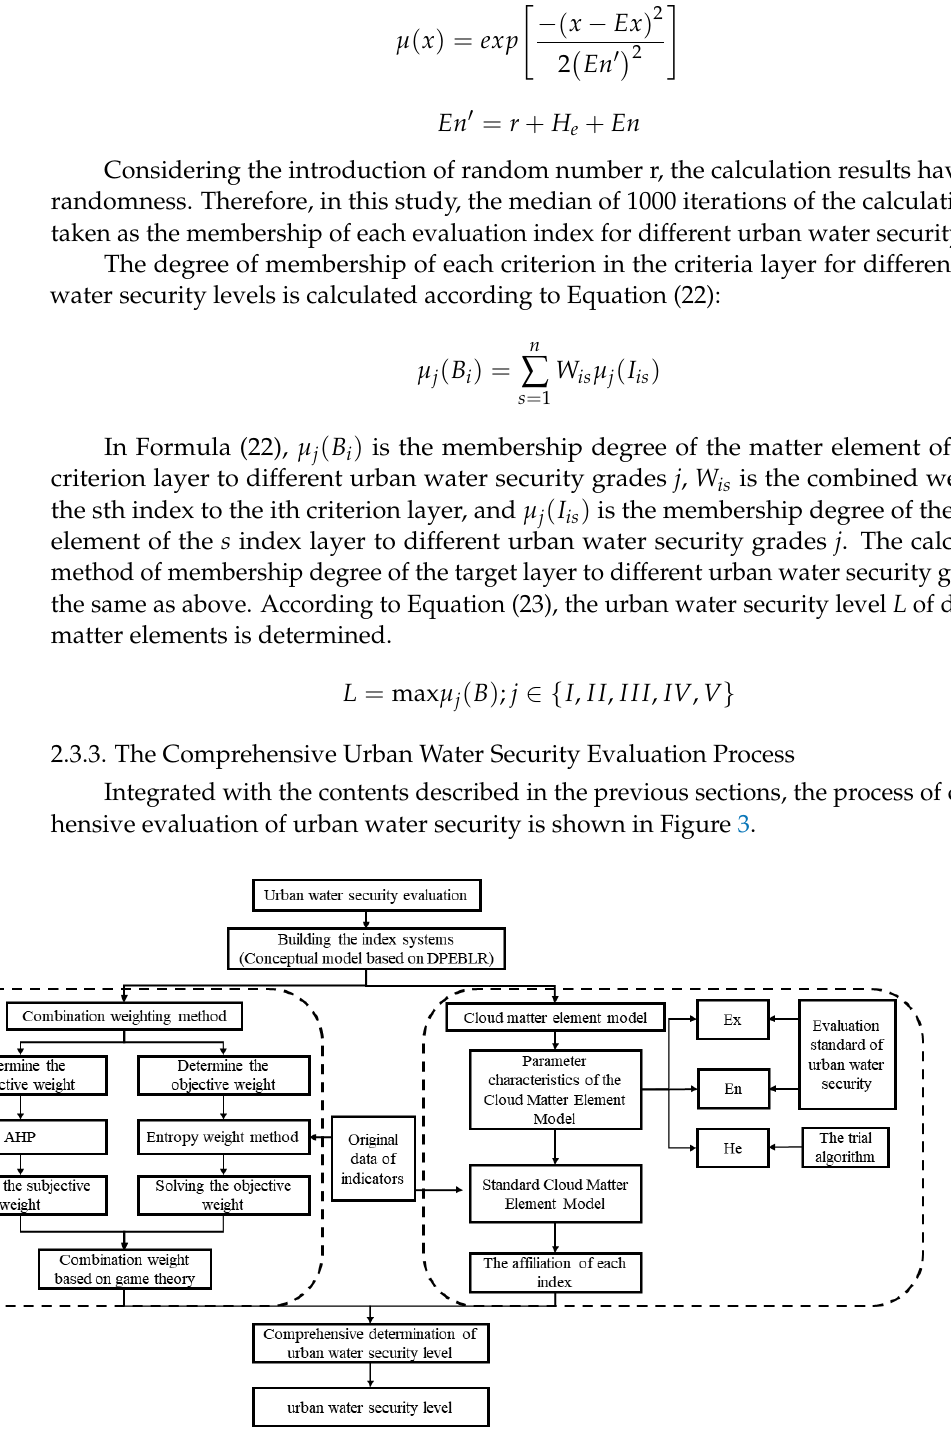
Figure 3. Urban water security assessment process based on DPEBLR conceptual model and com- bined weight cloud matter-element model.